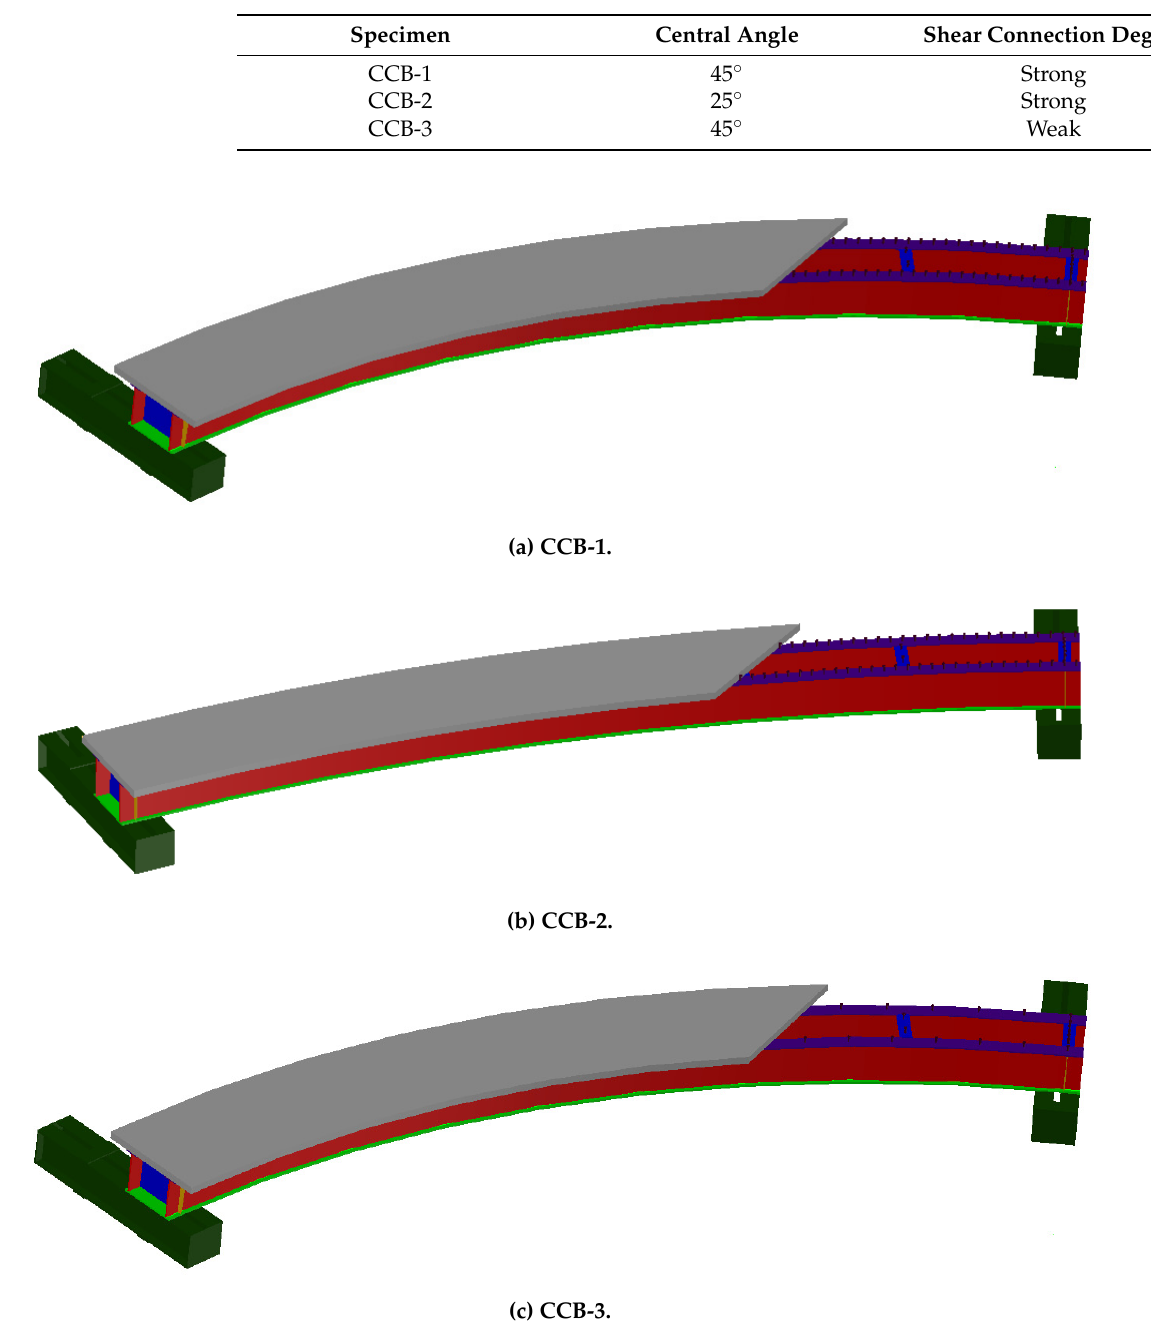
Figure 1. Schematic plots of the test